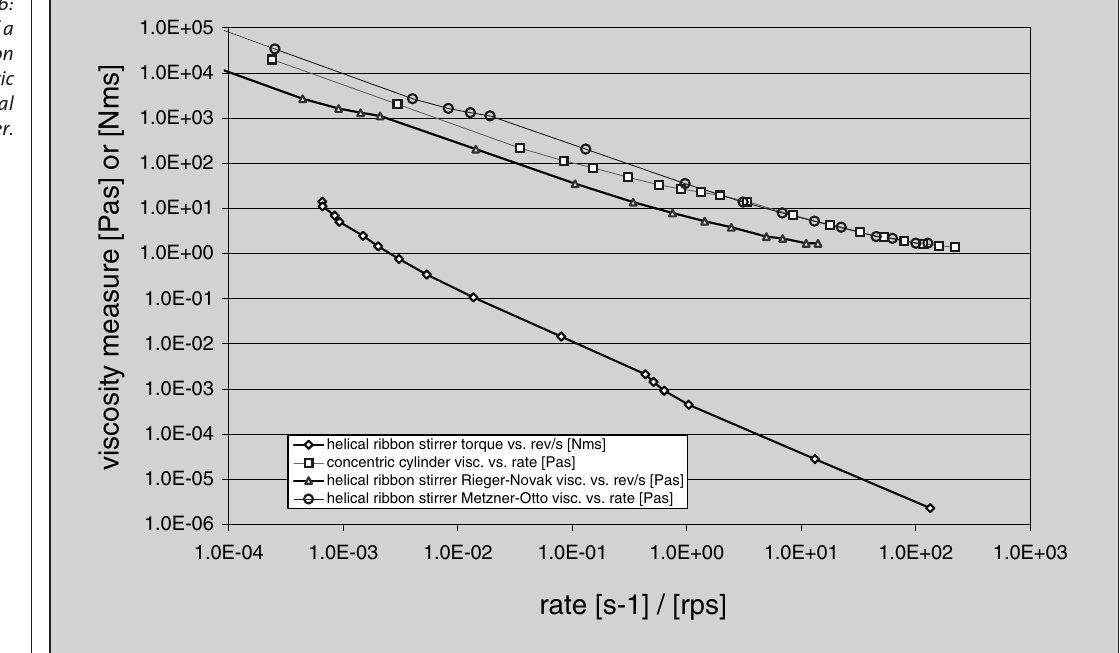
Figure 6: Flow curve of a suspension/emulsion mixture using concentric cylinders and the helical ribbon